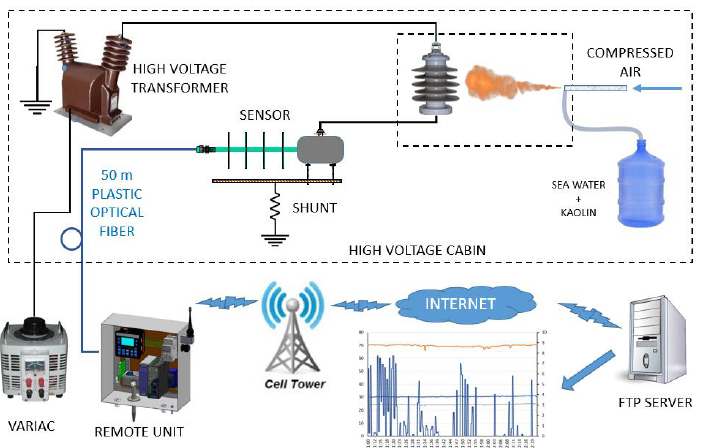
Figure 3. Block diagram of the high-voltage test chamber.